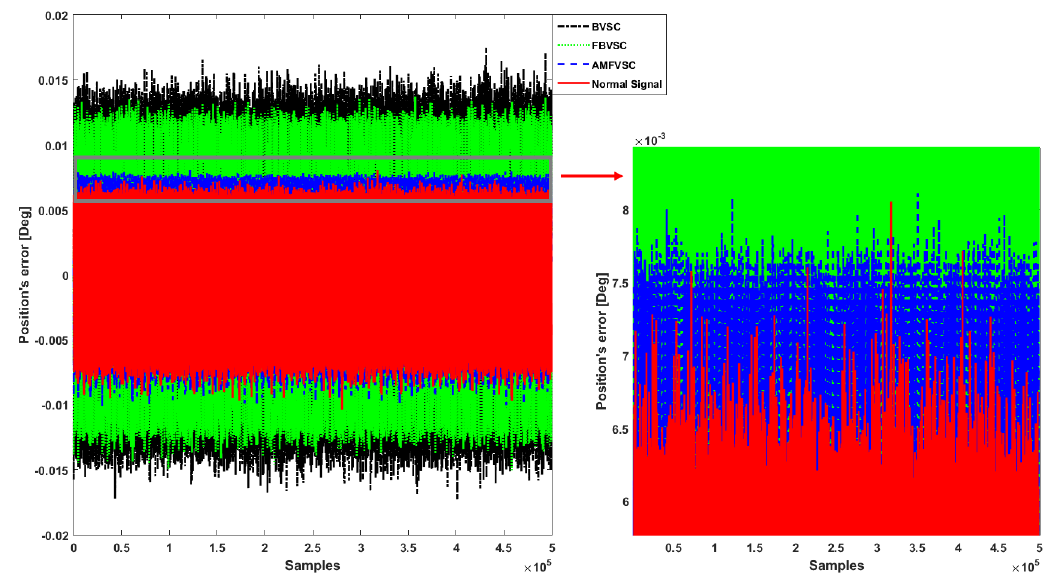
Figure 10. Sensor fault-tolerant control algorithm based on AMFBVSC, FBVSC and BVSC.